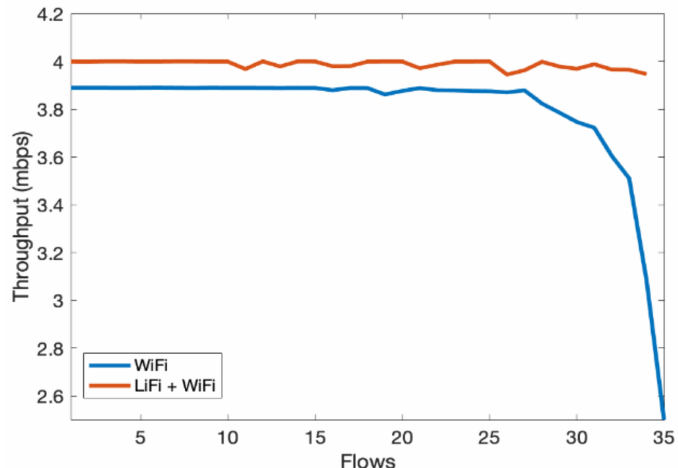
Figure 8. Per-user throughput vs. number of flows.